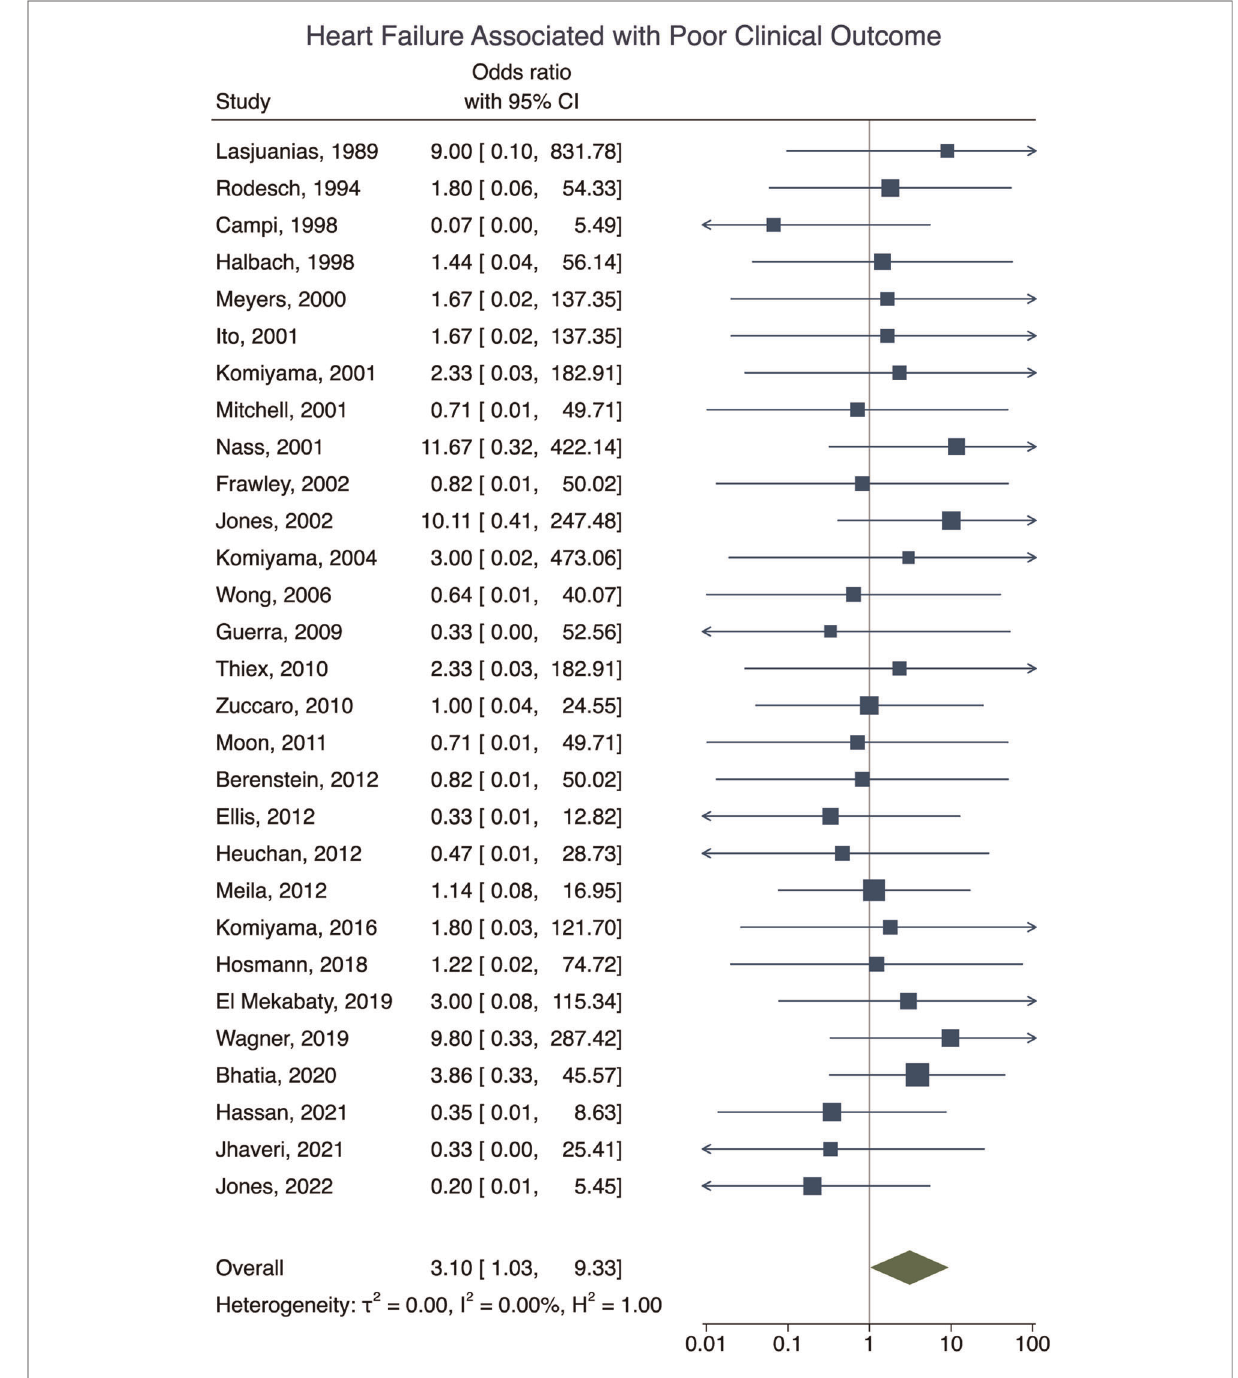
FIGURE 2 Forest plot showing the association of heart failure as a presenting symptom with poor clinical outcome after VOGM endovascular